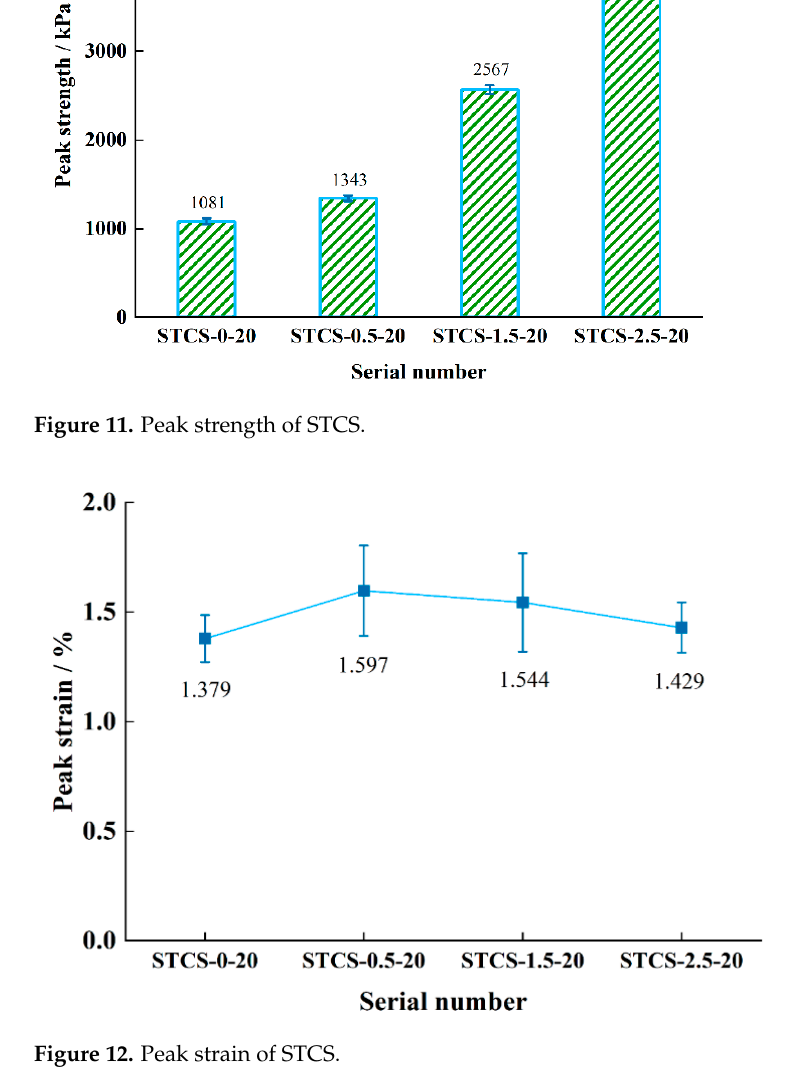
Figure 12. Peak strain of STCS.